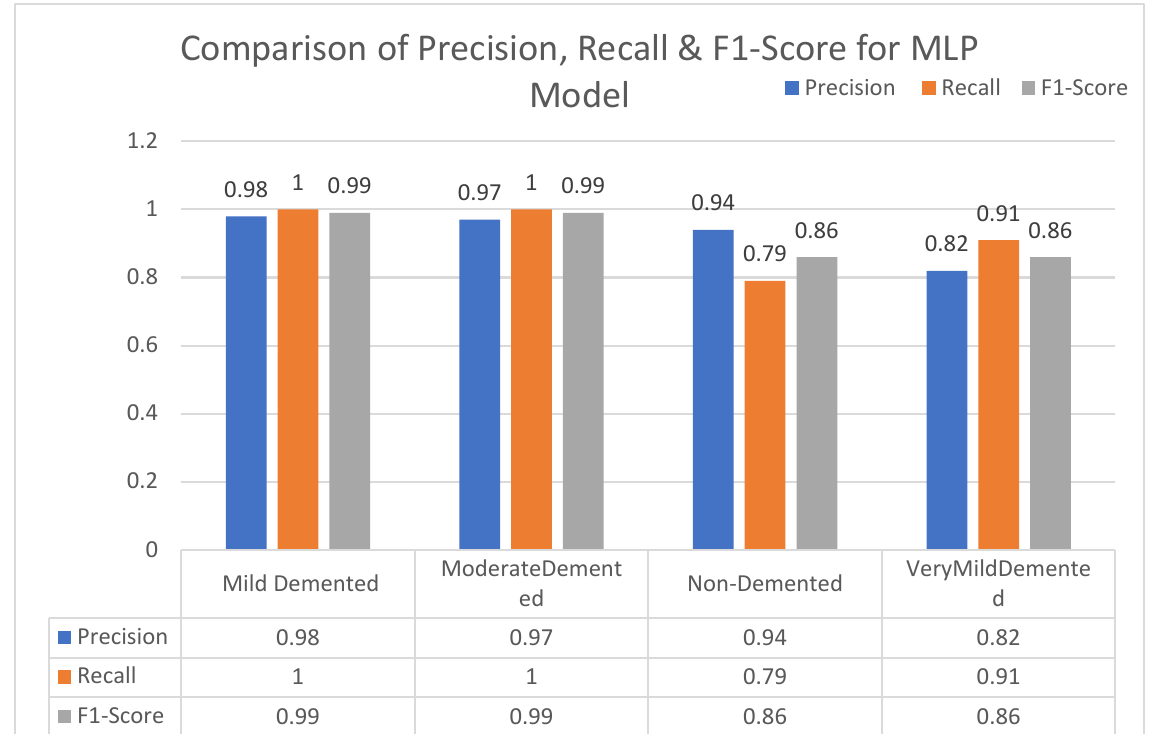
Figure 14. Visualization of Diagnostic Test for MLP Model.